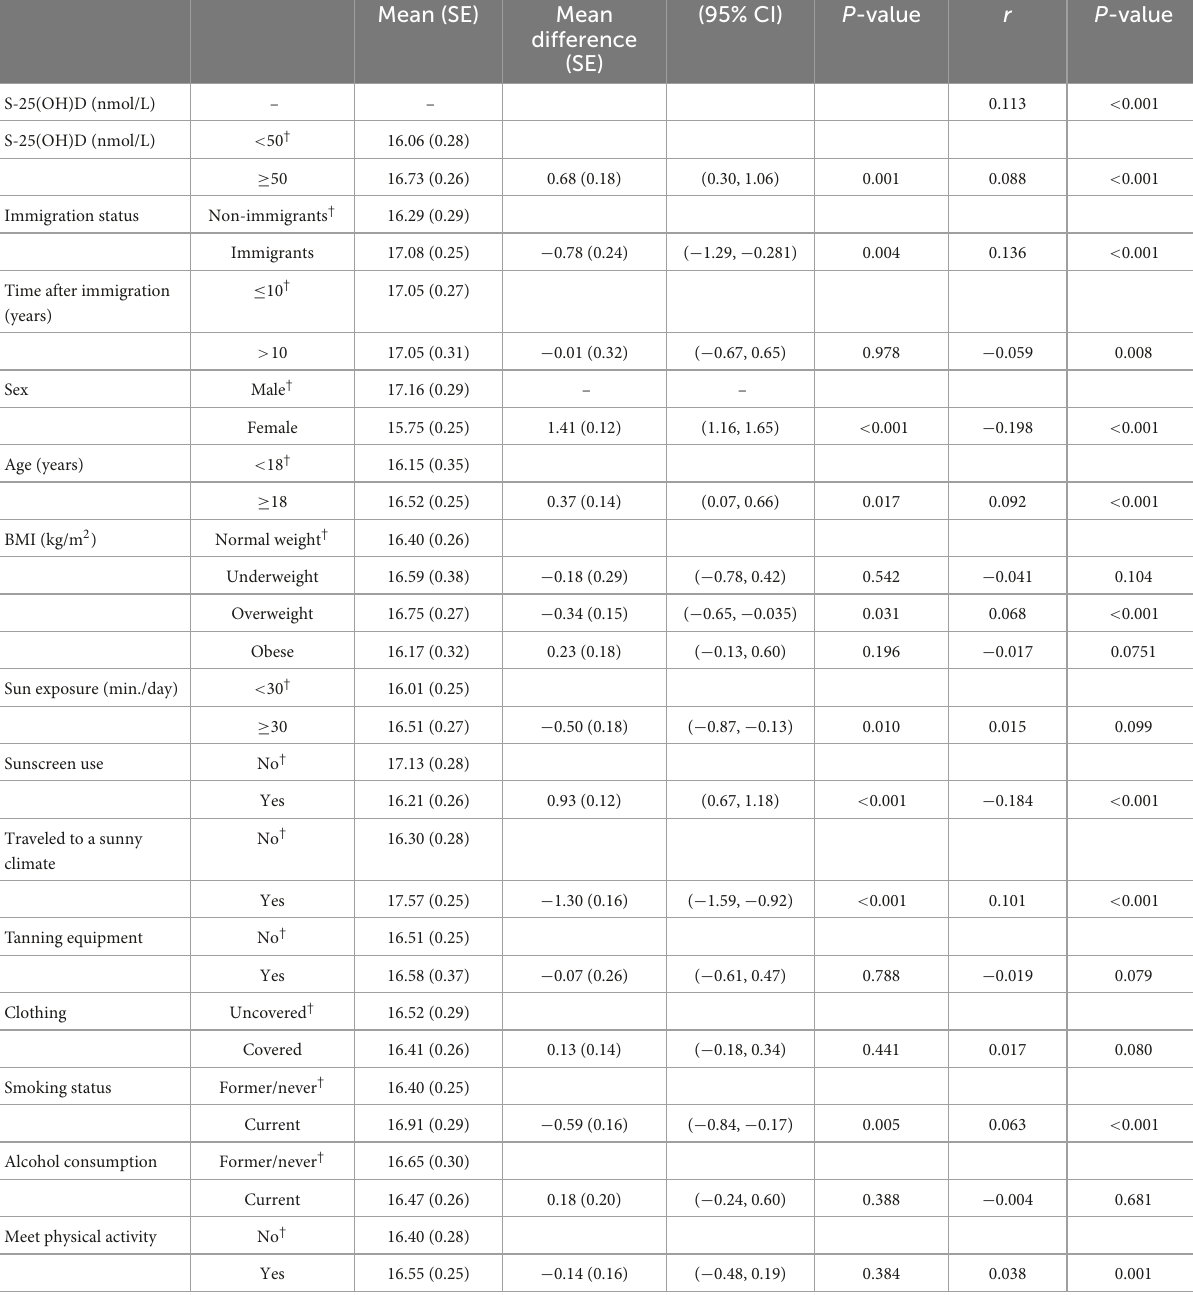
TABLE 1 Weighted mean melanin levels by S-25(OH)D, immigration, sociodemographic, and lifestyle factors using Canadian Health Measures Survey (CHMS) data (Cycles 3 and 4).